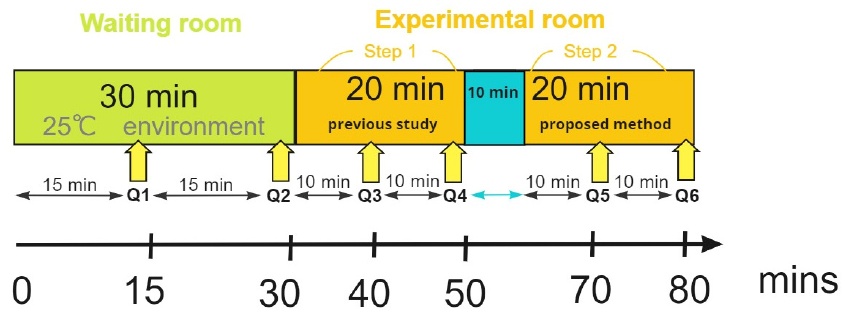
Figure 5. Experimental procedure.